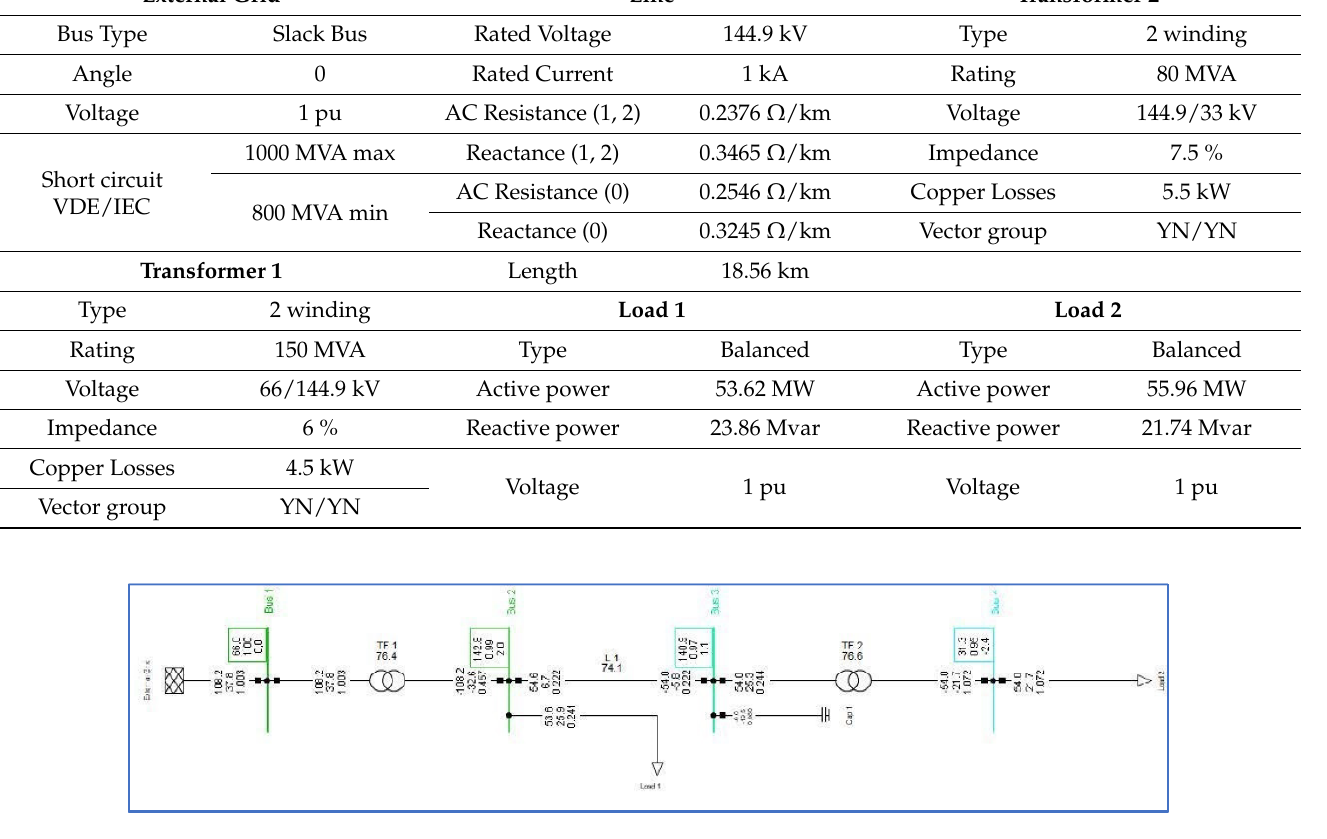
Figure 1. Load Flow Results of the network .